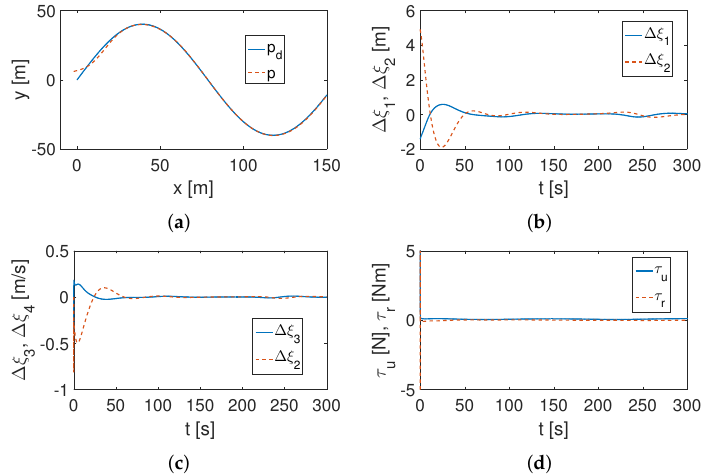
Figure 5. Simulation results for ROPOS original controller (CL) and sine trajectory: ( a ) desired and realized trajectory; ( b ) position error states; ( c ) velocity error states; and ( d ) applied force and